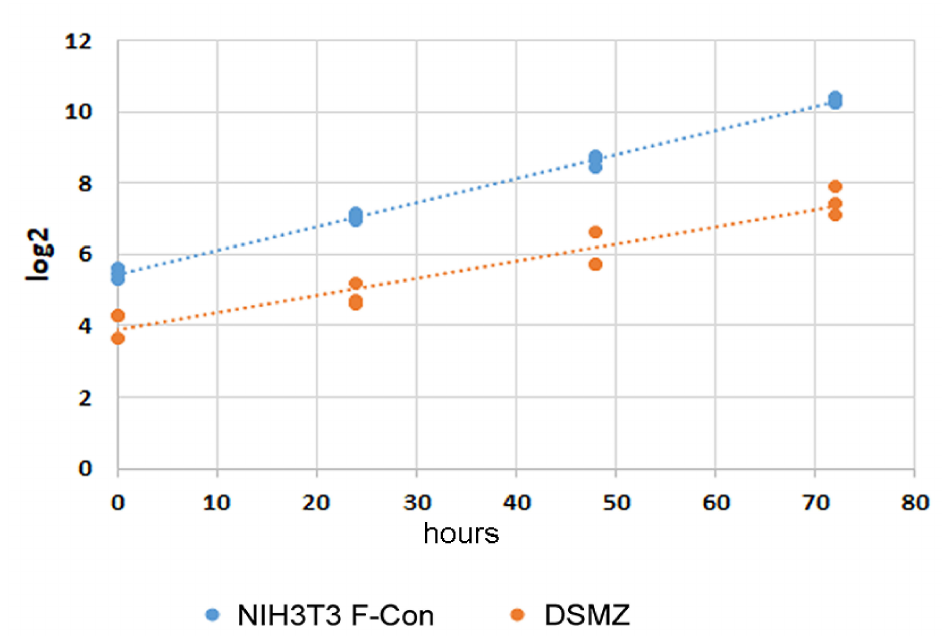
Figure 10. Loss of Atat1 expression correlates with increased proliferation rate. NIH3T3 sub-cell lines “DSMZ” and F-con were seeded in 12-well plates and cultivated in standard medium. At the indicated time points, cells were fixed and stained with DAPI. 20 pictures from each well were taken and the nuclei counted automatically. The growth curves were depicted as log2. Triplicate